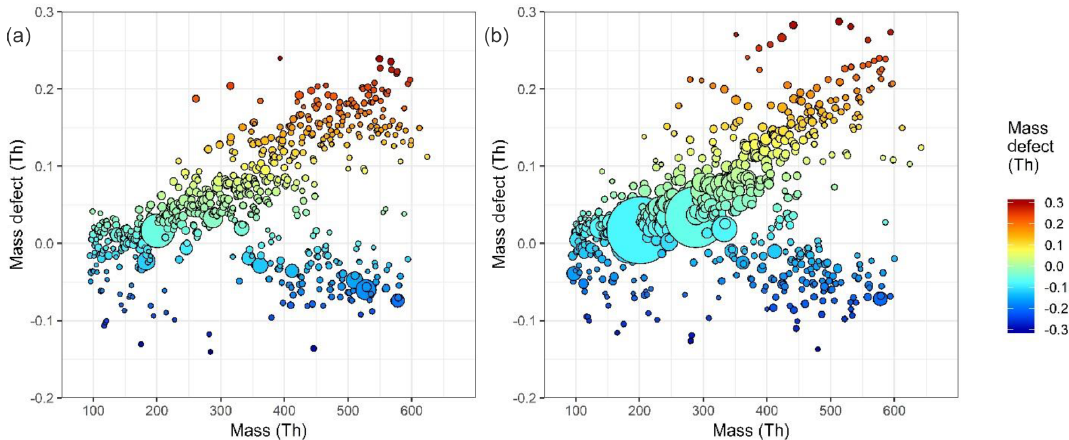
Figure 2. Mass defect plot of fitted mass spectral peaks between 100 and 600 mass units at (a) 10:30–12:00CST on 23 June 2017, a non- nucleation day, and (b) at 10:30–12:00CST on 25 June 2017, a nucleation day. Mass defect can be defined as the mass – integer mass. The size of point is proportional to the signal intensity. As 1 H has a positive mass defect (1.007276Da), the upward trend along the horizontal indicates increasing carbon chain length, and differences at similar masses are due to increasing oxygen functionality and clustering with species such as sulfuric acid (negative mass defect) and ammonia (positive mass defect), as 16 O and 32 S have negative mass defects (15.9949 and 31.9721Da respectively), while 14 N has a positive mass defect at 14.0031Da. The two large peaks seen at 201 and 288 m/Q are